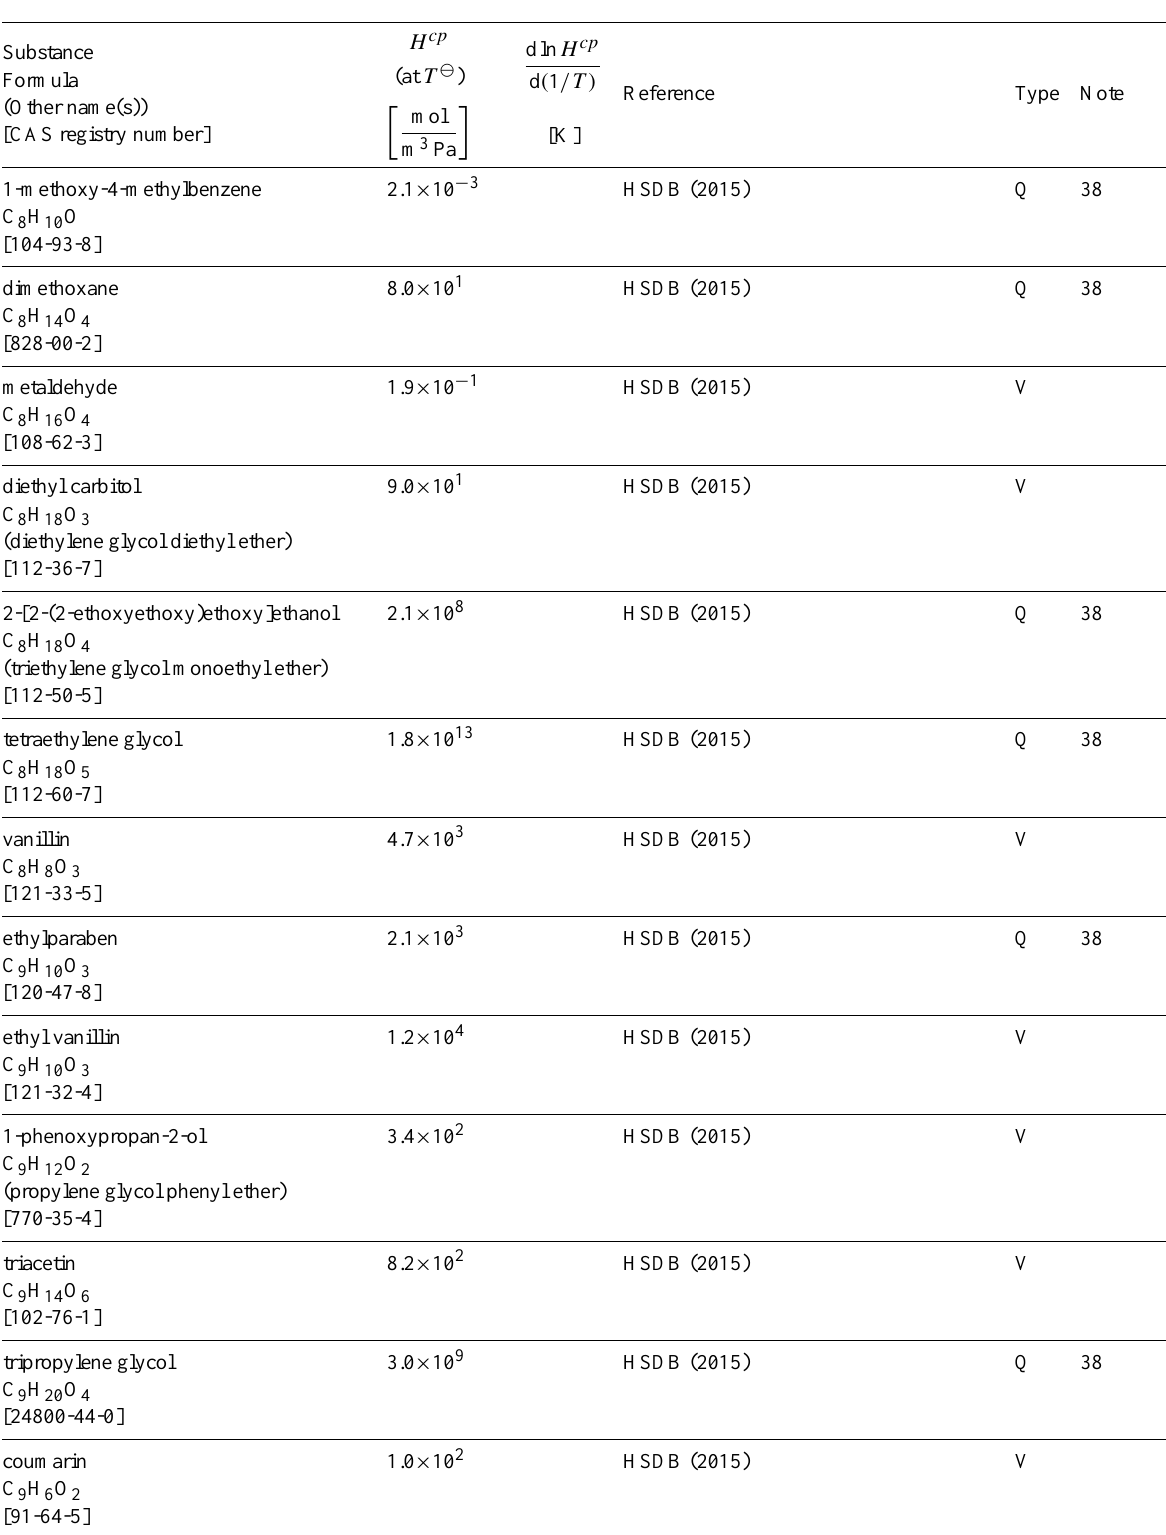
Table 6: Henry’s law constants for water as solvent